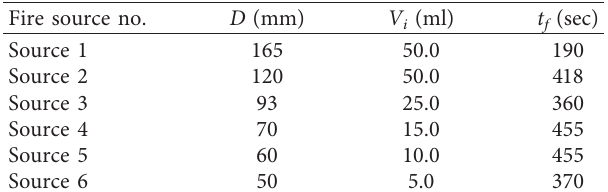
Table 2: Results of the duration of fire according to each fire source used.